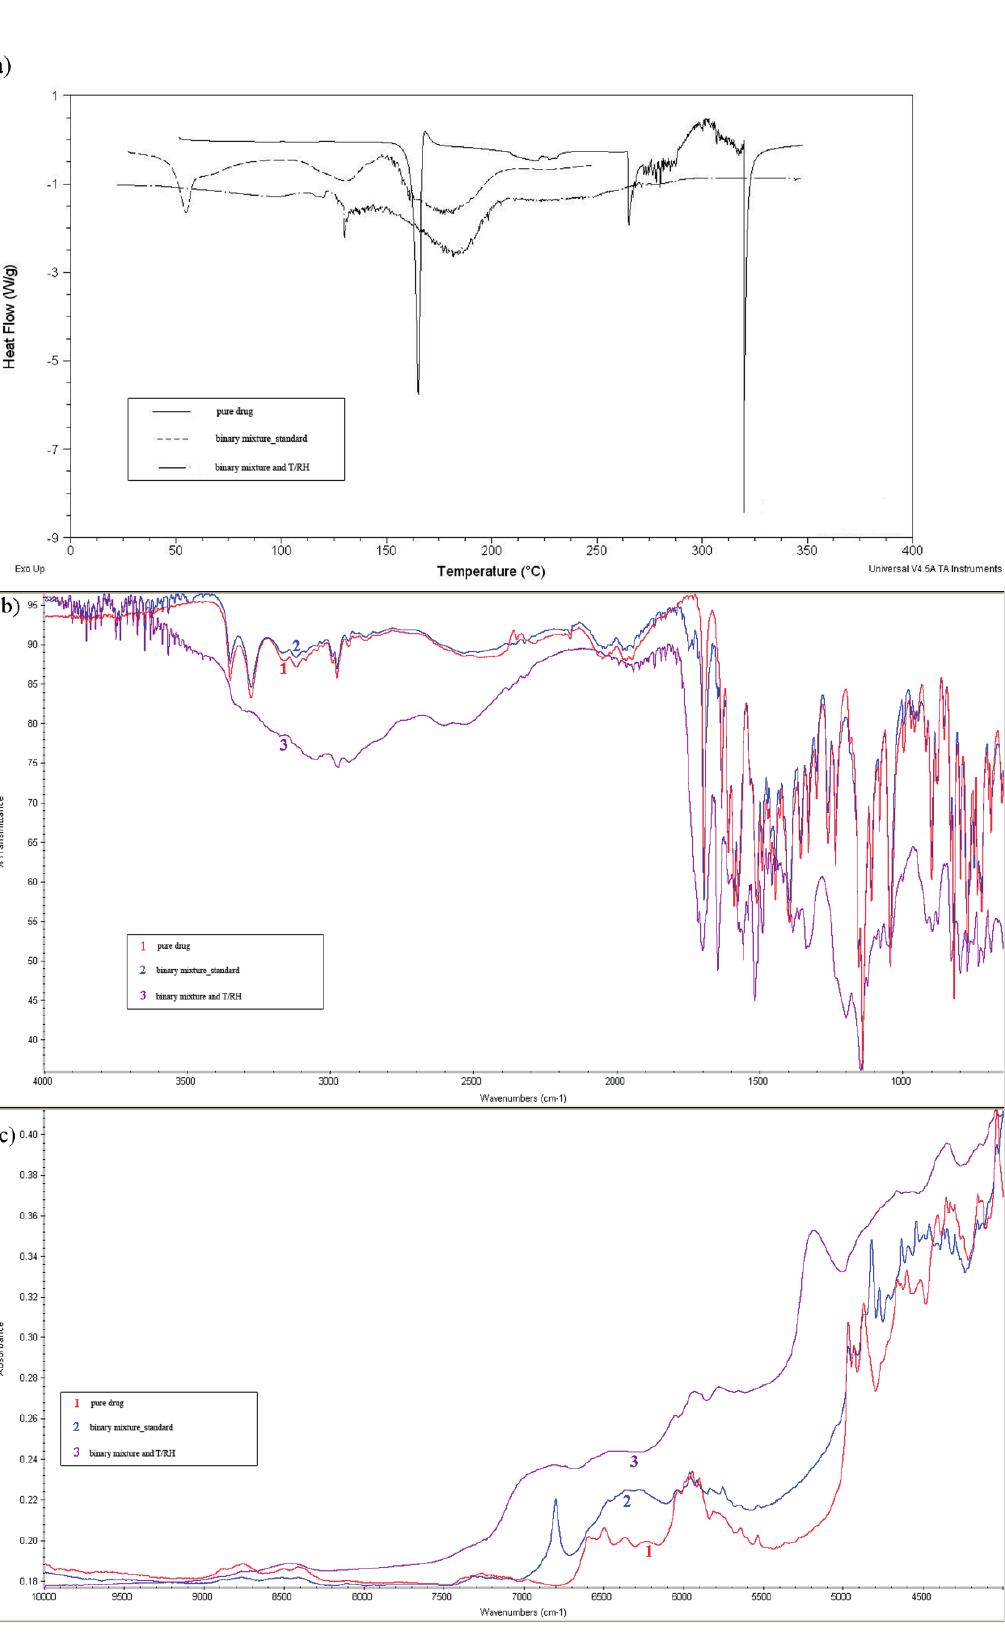
Figure 1 : Torasemide and citric acid: DSC scans (a), FT-IR spectra (b) and NIR spectra (c) for the mixture stressed with high temperature/ humidity (T/RH) and the untreated mixture (standard) against pure